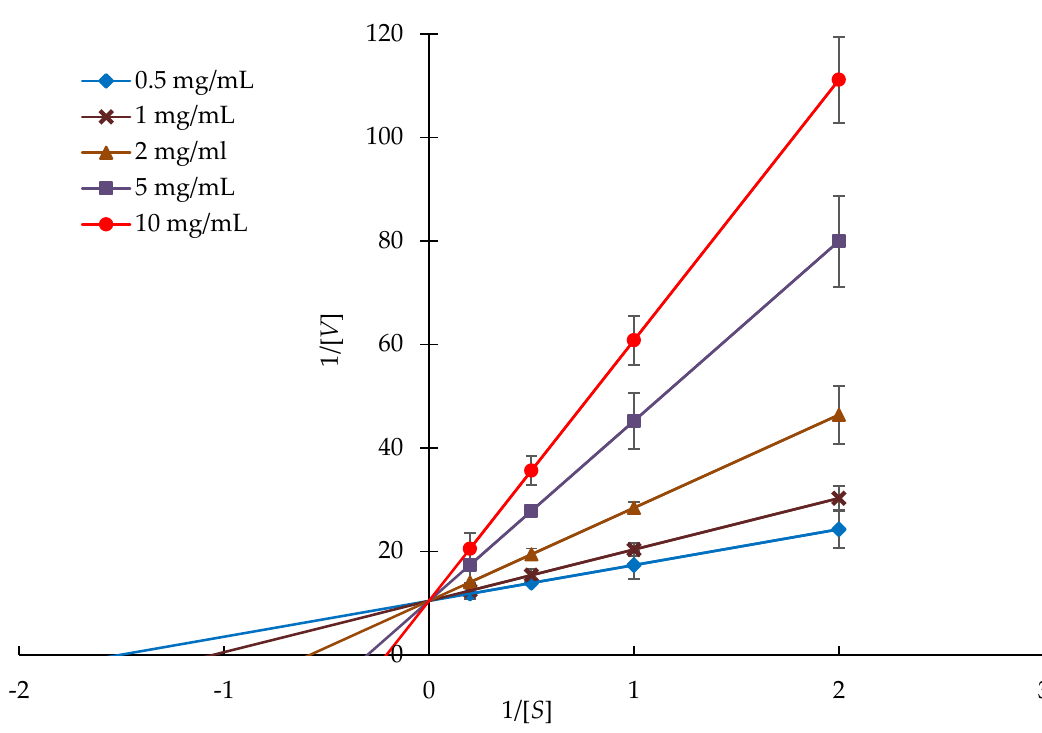
Figure 5. Lineweaver–Burk double reciprocal plot for rice protein hydrolysate concentration as a parameter ([ V ]: absorbance change rate, ∆ OD 600 / min, and [ S ]: HA concentration).